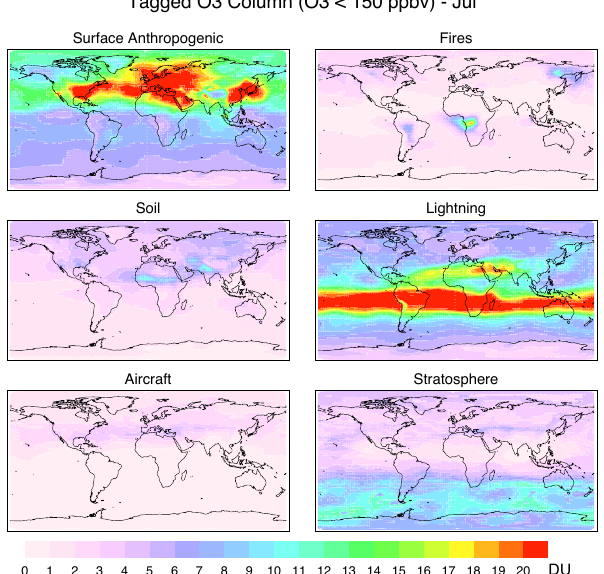
Fig. 2. Tropospheric columns of each tagged ozone source for Jan- uary 2008. Stratospheric contribution is determined as the differ- ence between total ozone and tagged ozone from all tropospheric sources. The chemical tropopause of O 3 at 150 ppbv is used.